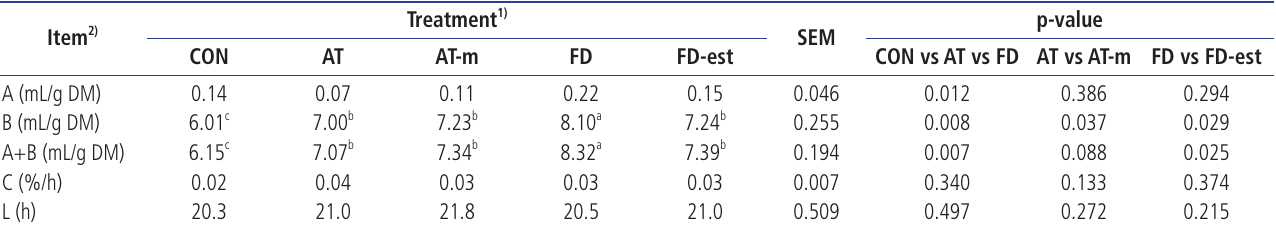
Table 5. Effects of rye silages treated with wild and mutated inoculants on rumen fermentation kinetics incubated for 96 h Item